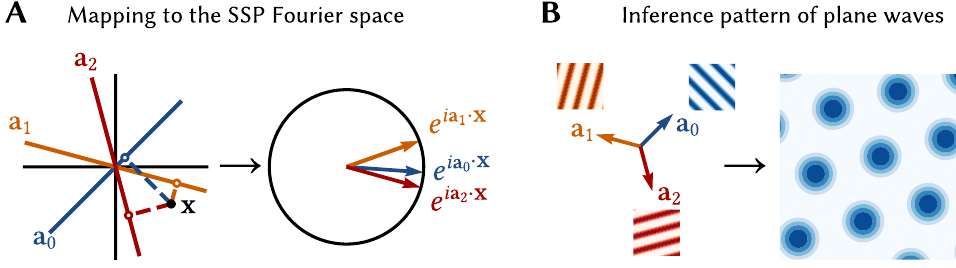
Figure 8. ( A ) Illustration of the projection to the frequency domain of the SSP space given in Equation (4). The dot products between a 2D variable x and a set of three vectors { a j } are cast as the phases of a set of phasors, { e i a j · x } , which reside on the unit circle in the complex plane. The IDFT of the vector [ e i a 0 · x , e i a 1 · x , e i a 3 · x ] is a SSP representation of x , which resides in a higher dimensional vector space. In this example, the SSP is only 3-dimensional, but in practice a much larger set { a j } is used to produce high dimensional SSPs. ( B ) Consider how these phasors change for a x (cid:48) traversing 2D space. The banded heat maps shows how the real part of the vectors { e i a j · x } repeats over a 2D region of x (cid:48) values. Each component of the SSP in the Fourier domain is a plane wave with wave vector a j . The gridded heat map is the similarity between the SSP representation of x from (A) and SSPs of neighboring points: φ ( x ) · φ ( x (cid:48) ) . The similarity map is periodic due to the inference pattern of all plane waves. Here a hexgaonlly gridded similarity pattern is